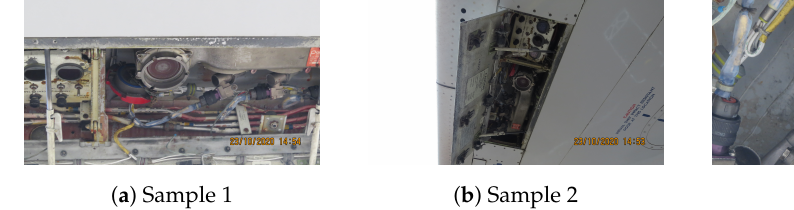
Figure 2. Sample Images from Real Dataset.